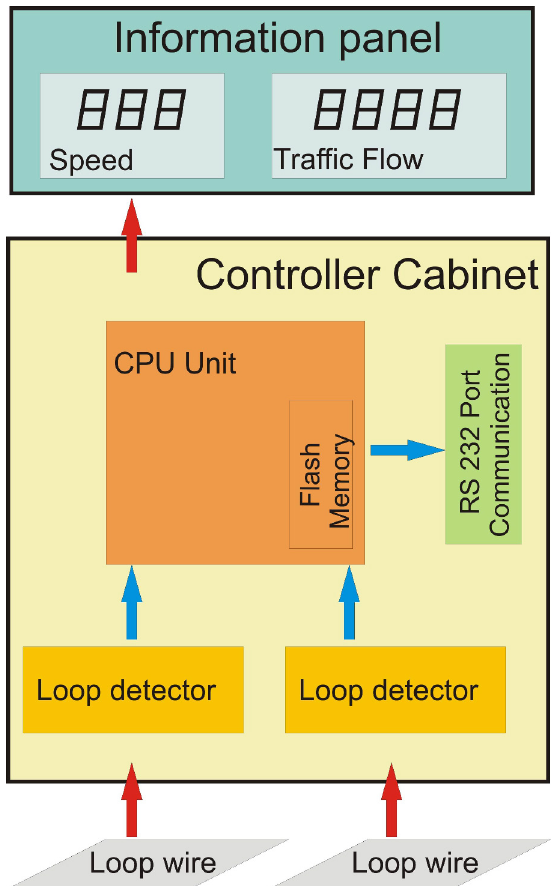
Figure 4. The information link between the system components